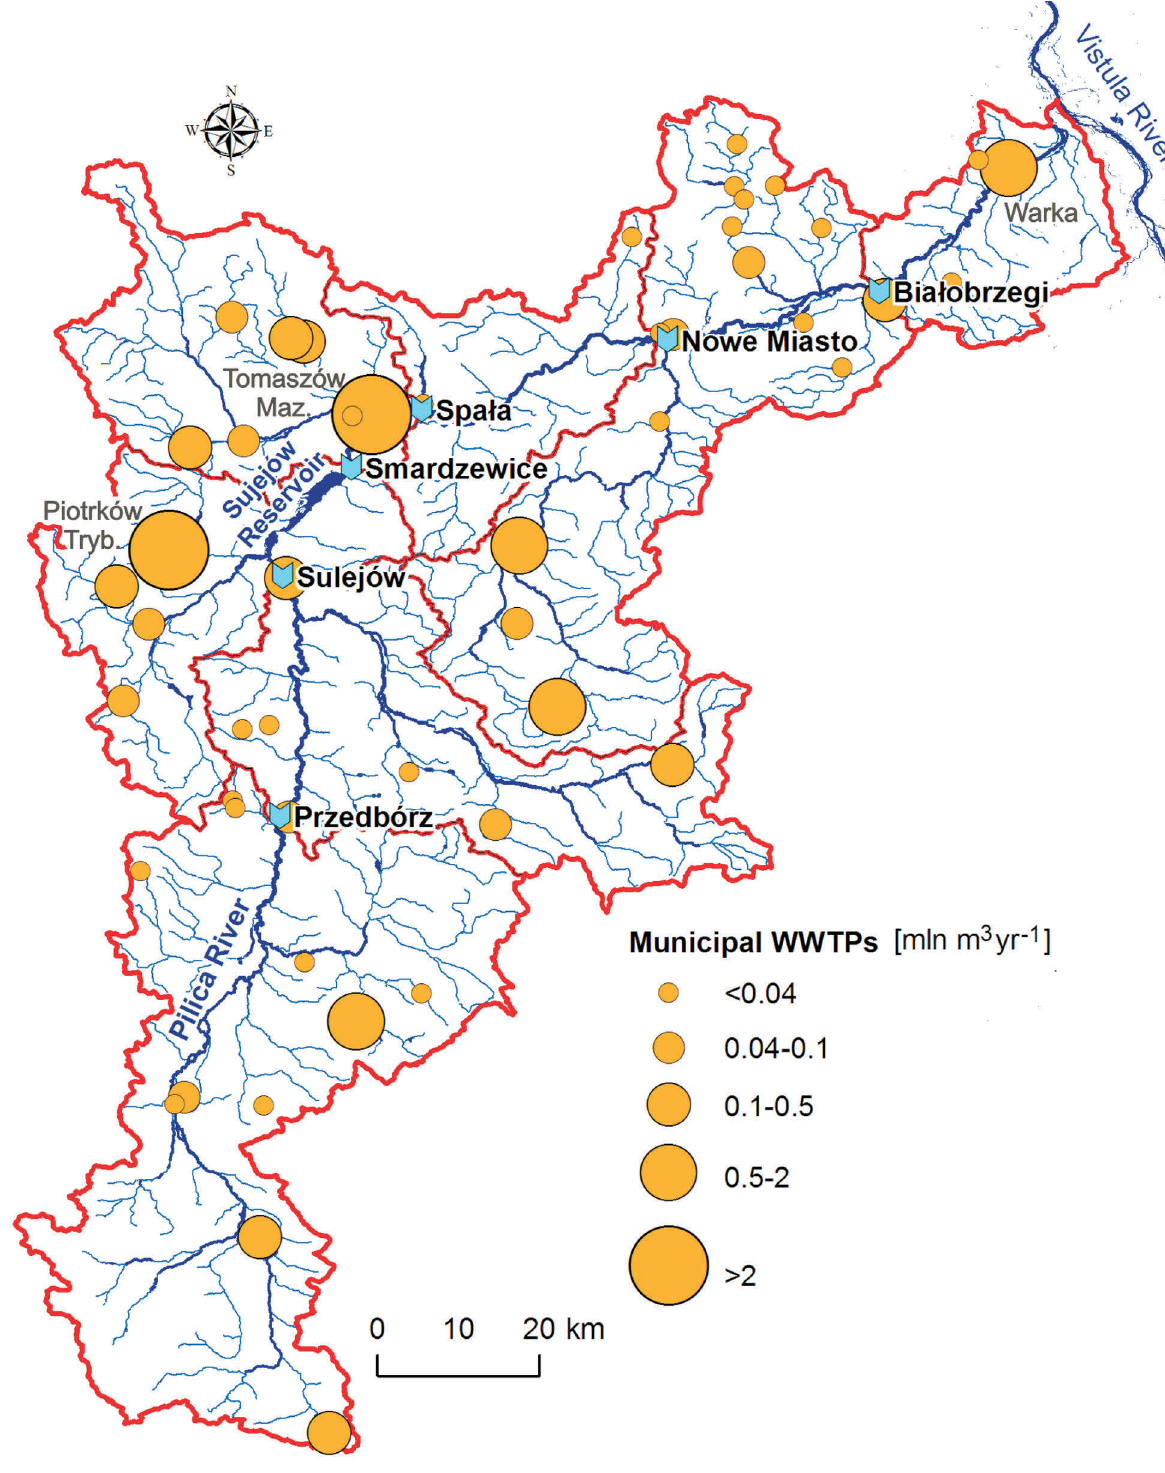
Fig. 3. Location and volume of wastewater outflows from municipal WWTPs in the Pilica River sub-catchments in